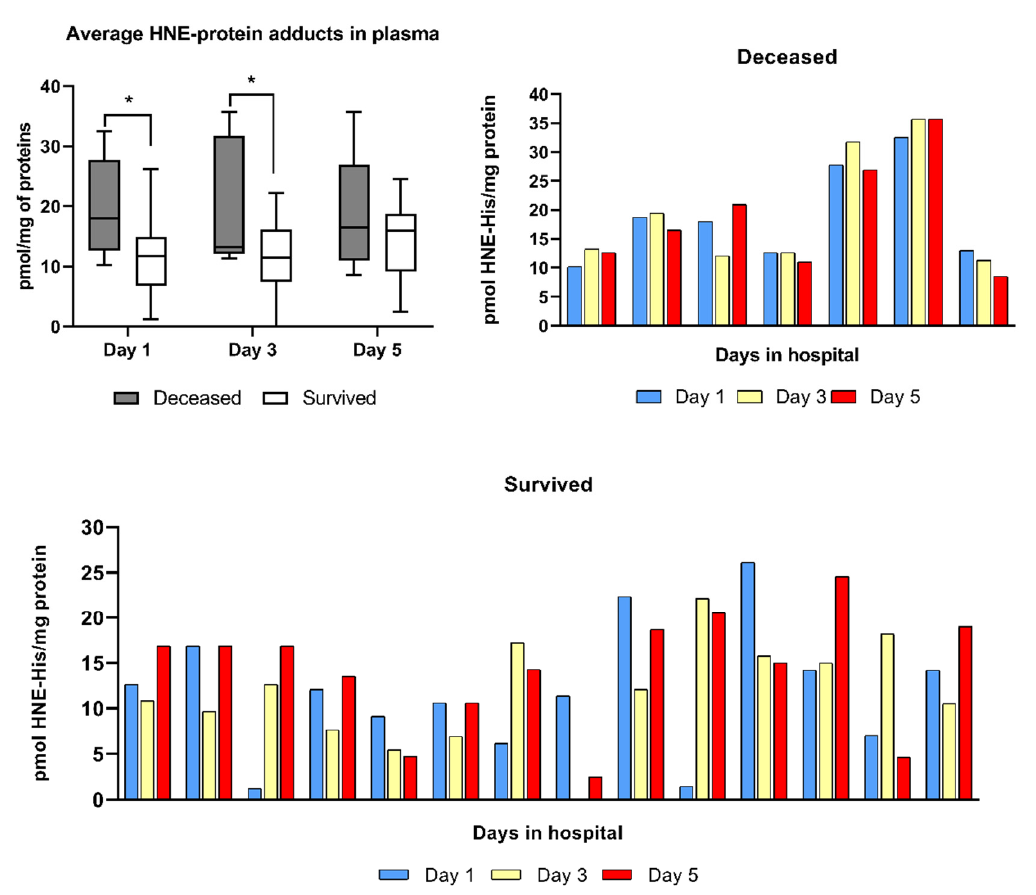
Figure 1. Values of the HNE-protein adducts determined in the EDTA-plasma of COVID-19 patients by the genuine HNE-ELISA specific for the HNE-His adducts. The amounts of the HNE are presented in pmol/mg protein values, while the asterisk indicates a significant difference ( p < 0.05) between the average values determined for the plasma of survivors and for the deceased COVID-19 patients.